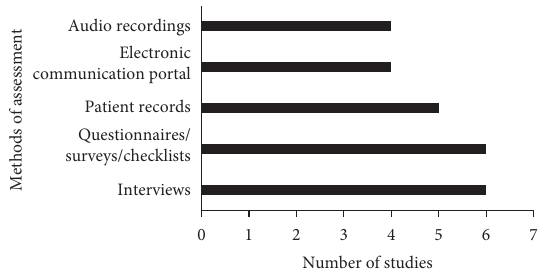
Figure 6: Methods used to assess satisfaction of patients with the discharge